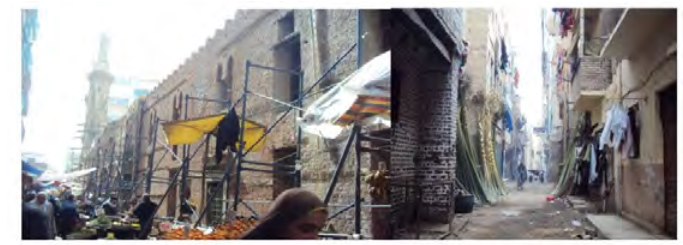
Figure 13. (Daily market & local